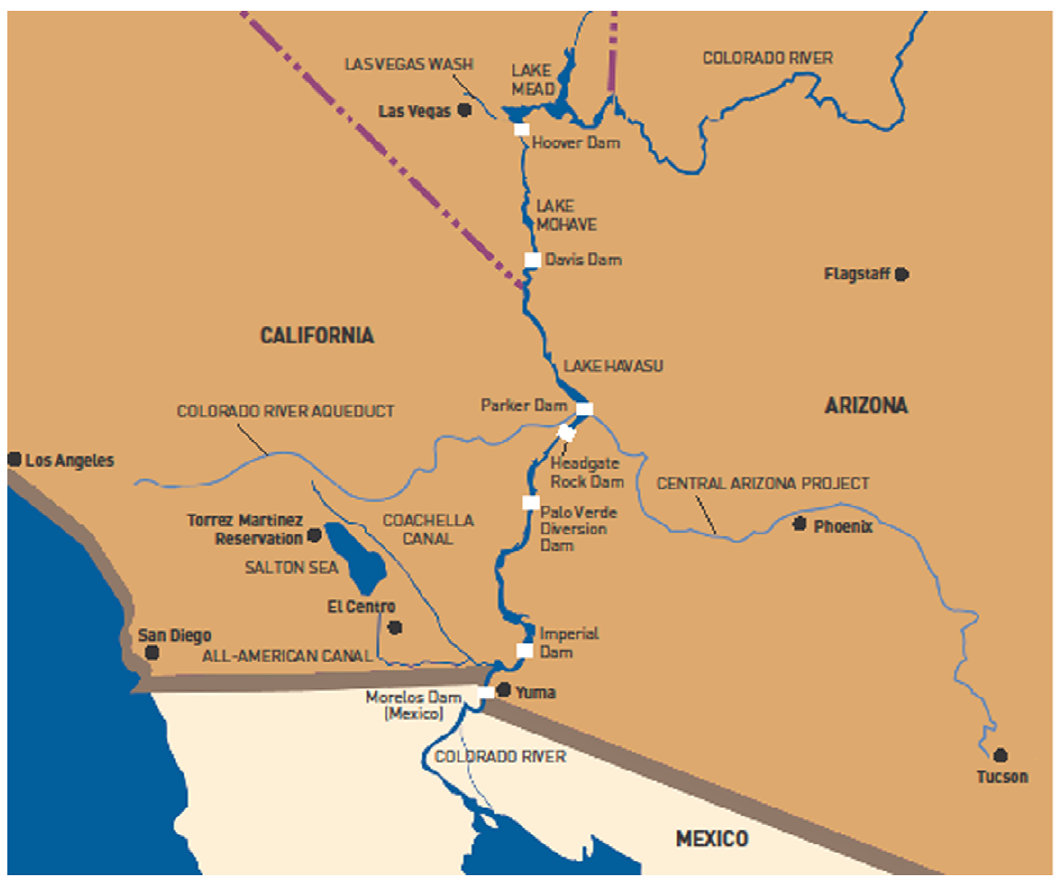
Figure 1. Map showing the Lower Colorado River from the source of perchlorate contamination in the Las Vegas Wash to the All- American Canal in the Imperial Valley. Source: U.S. Bureau of Reclamation.